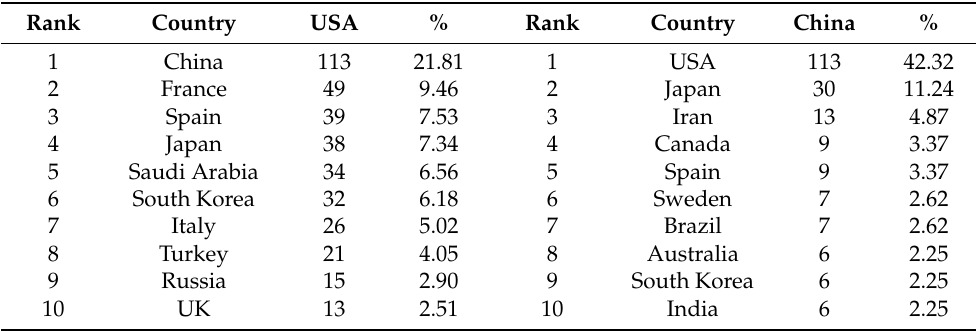
Table 2. The number of articles published in the top ten countries displaying cooperation between the United States and China from 1998 to